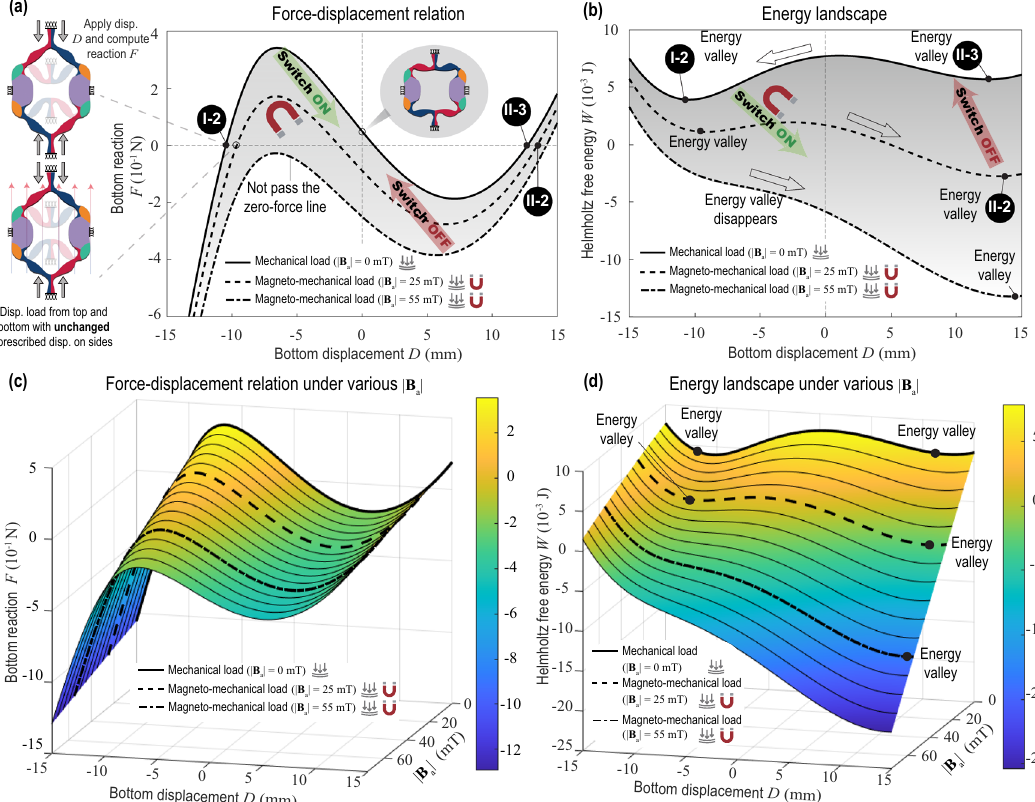
Fig. 6 Force-displacement responses and energy landscapes to understand the underlying behavior of bistability. a Boundary condition illustration and force-displacement responses; b Energy landscapes; c , d 3D contour plots of force-displacement relations and energy landscapes, respectively (as functions of the bottom displacement and the magnitude of applied magnetic fi